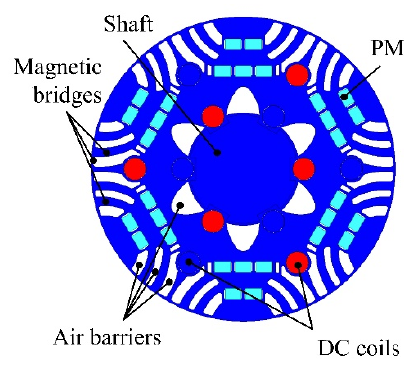
Figure 3. View of the machine rotor.